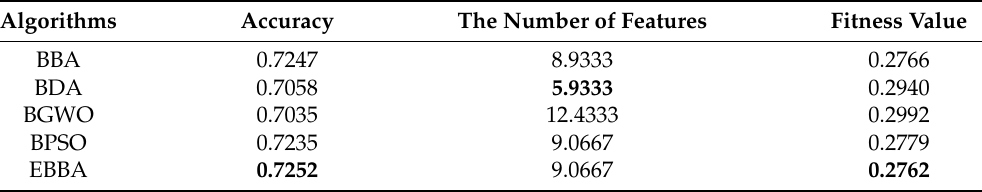
Table 6. Optimization results obtained by different algorithms under random forest. (The best values are highlighted in